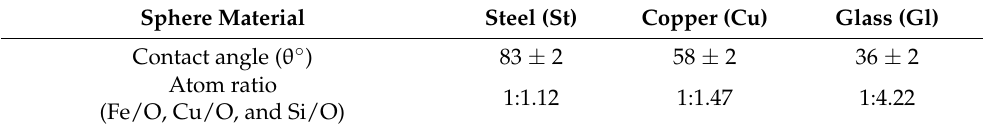
Table 2. Contact angle for the considered spheres and the atom ratio for key elements. Sphere Material Steel